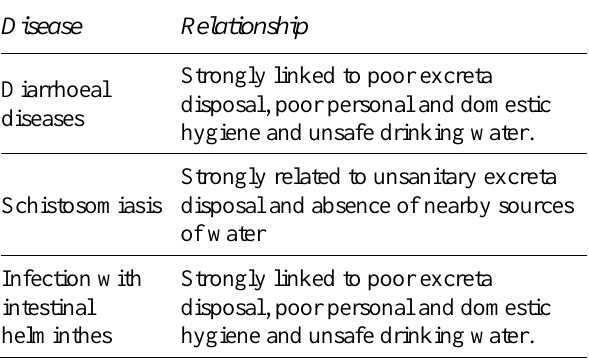
Table 3: Relationship between poor sanitation and selected diseases Disease